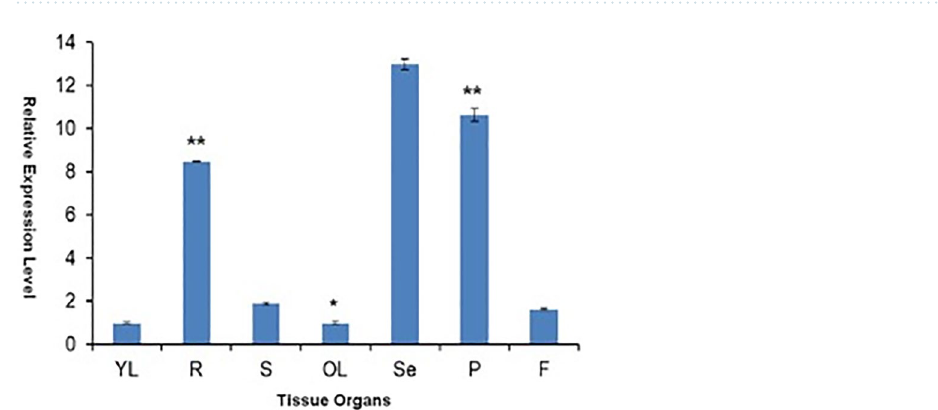
Figure 6. The tissue-specific expression pattern analysis of the GsPUB8 gene in multiple organs of G. soja . The plant organs used in this experiment included (YL) young-leaf, (S) stem, (R) root, (OL) old-leaf, (F) flower, pod (P) and (Se) seed. Error bars signify the ± SE (n =